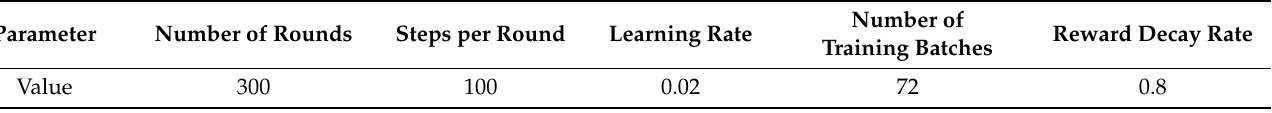
Table 6. DRL-Fuzzy-PID Controller Experimental Parameter Values.